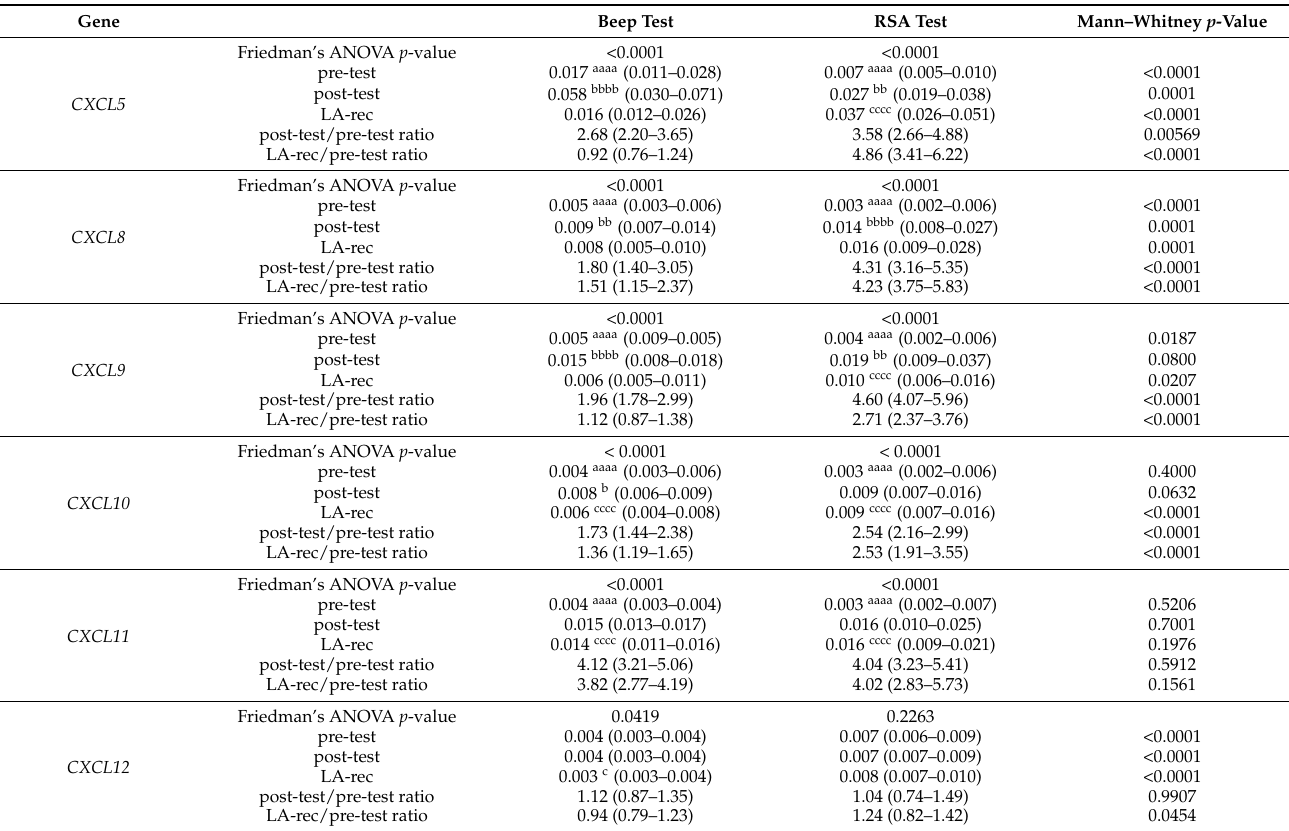
Table 4. The expression (2 − ∆ Ct values) of genes encoding selected chemokines of studied participants’ blood